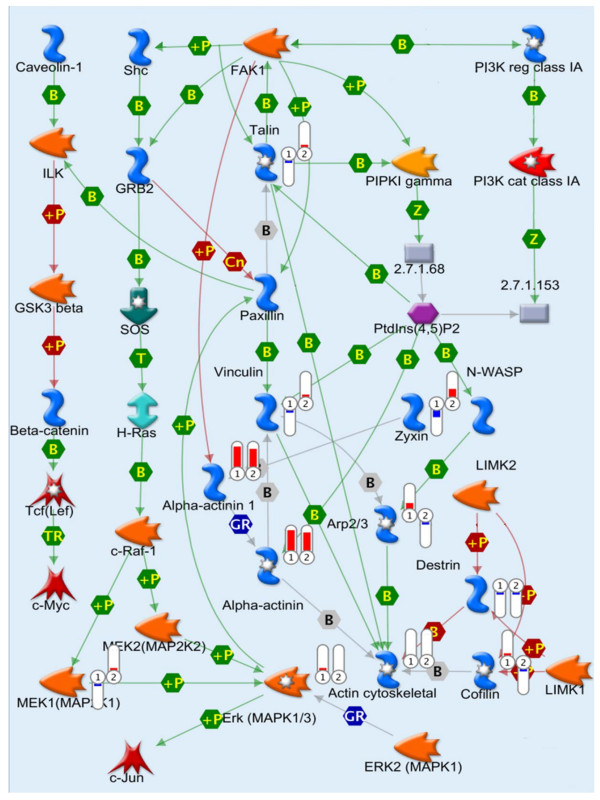
Map of cytoskeleton remodeling pathway (Genego Metacore, fragment) overlapped with quantile-normalized estimations of protein abundance. Flags indicate direction of change (red, up-increased, blue; down-decreased) and fold change (length) of protein abundance in relation to non-treated control. 1, IGF-1 and 2, Resveratrol. Results were expressed as mean for three replicate experiments for each treatment group.